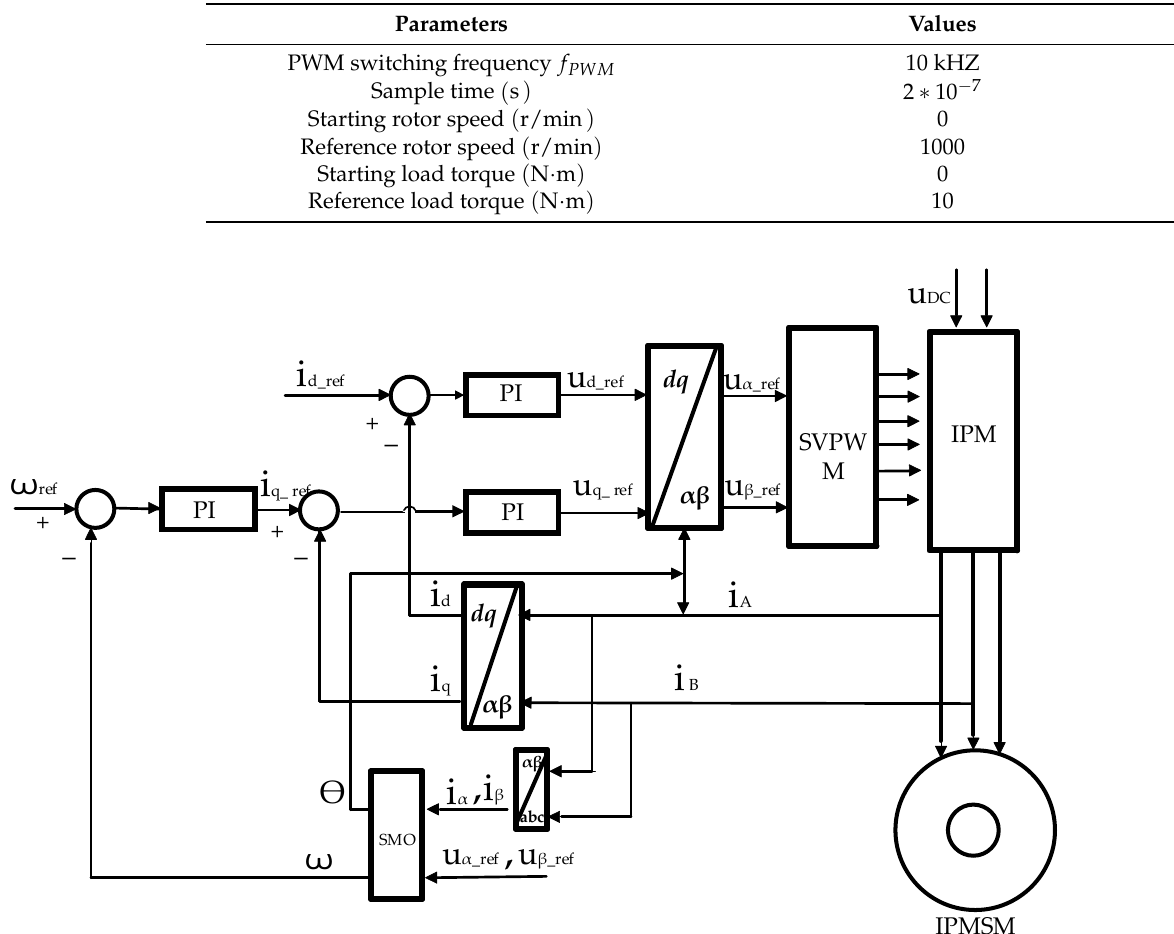
Figure 3. Structure diagram of the sensorless vector control system of permanent magnet synchronous motor. Table 1. Simulation parameters.